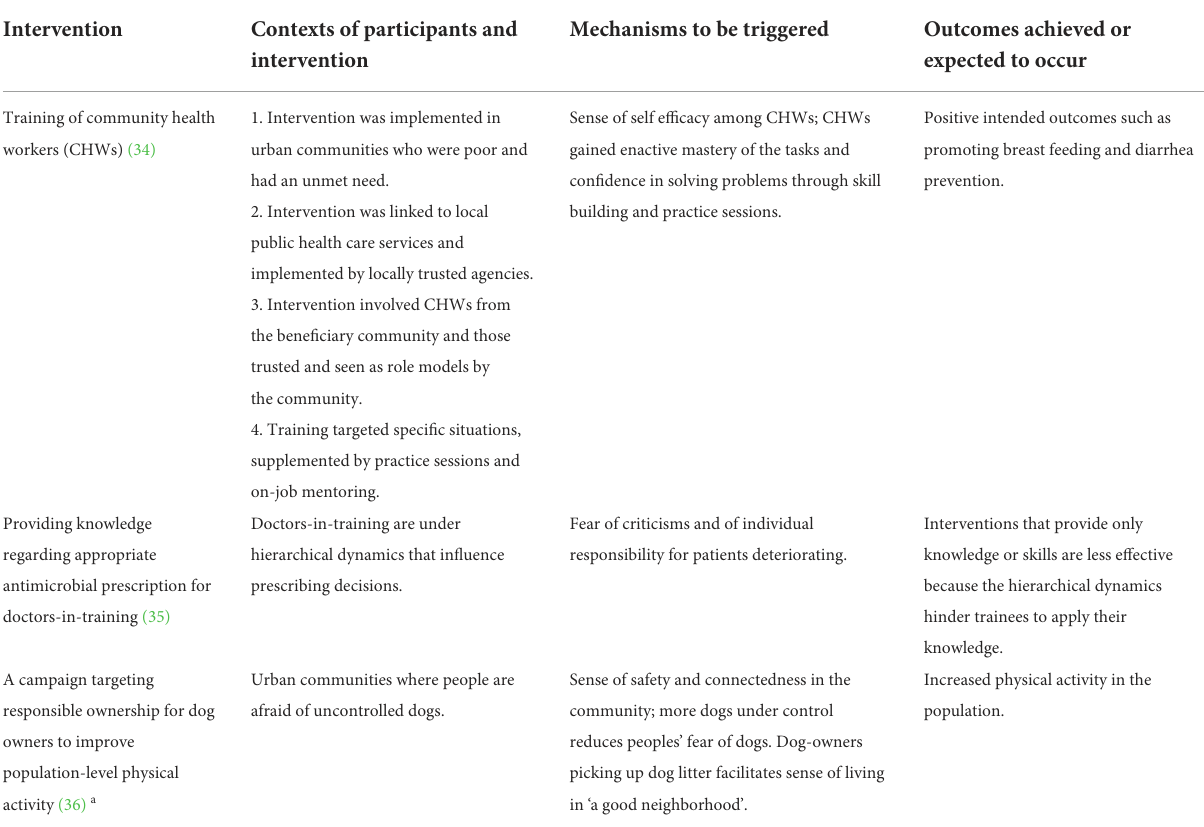
TABLE 1 Examples of context-mechanism-outcome configurations. Intervention Contexts of participants